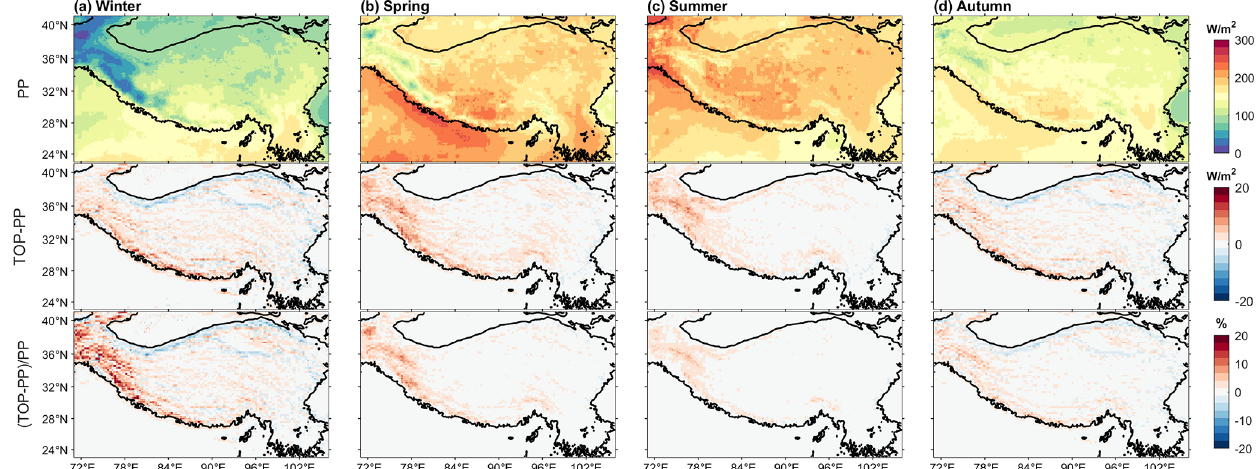
Figure 3. PP-simulated net solar radiation for different seasons (top row), and absolute (middle row) and relative (bottom row) differences between TOP and PP for different